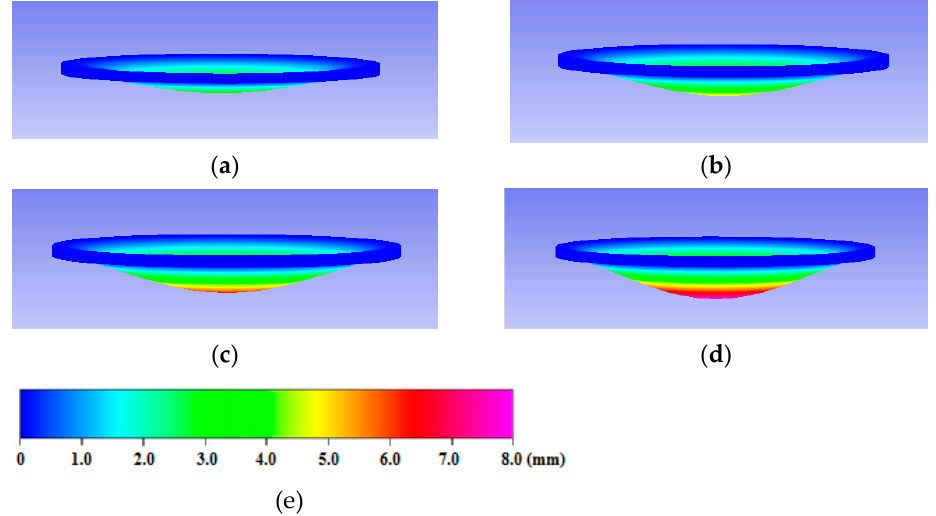
Figure 6. Numerical deformations of the actuated membrane under the pressures of ( a ) 20.68 kPa, ( b ) 34.47 kPa, ( c ) 48.26 kPa, ( d ) 68.95 kPa, and ( e ) deformation contour legend.